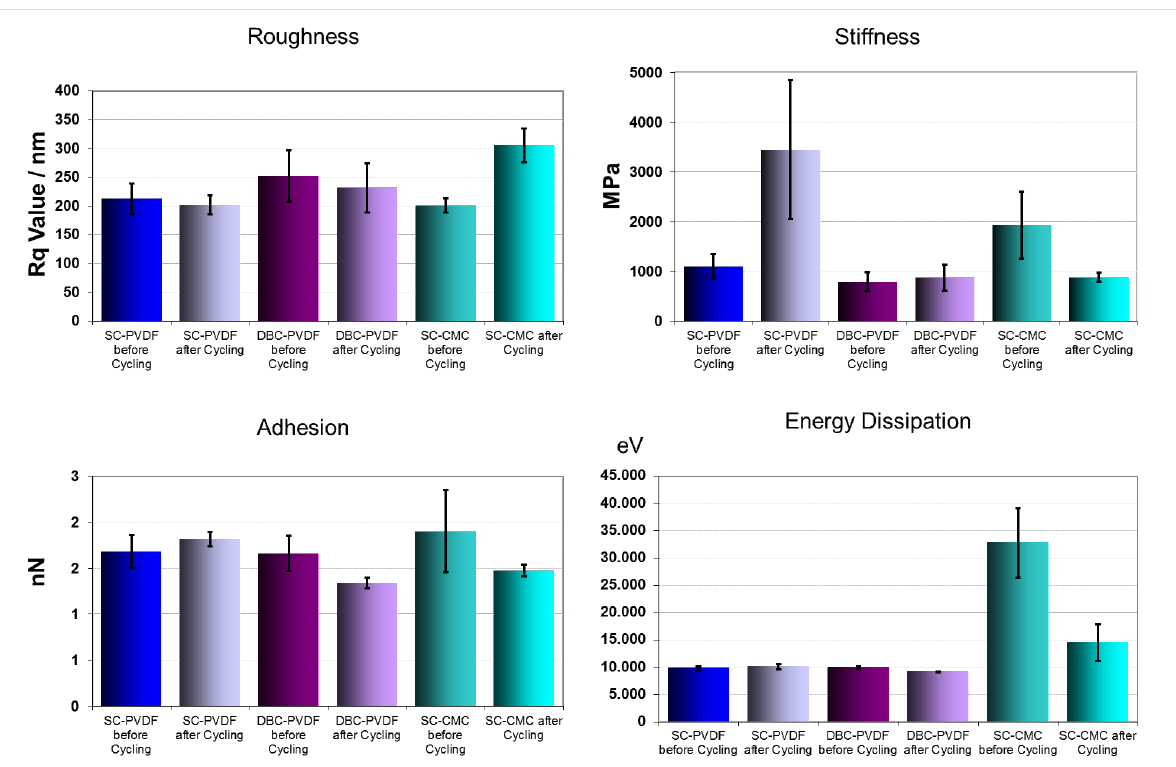
Figure 9: Comparison of mean values of roughness, adhesion, energy dissipation, and stiffness, from statistical evaluation of AFM images measured under identical conditions at the cathodes before and after 50 cycles; the imaged area is 3 μ m × 3 μ m with the same AFM tip.